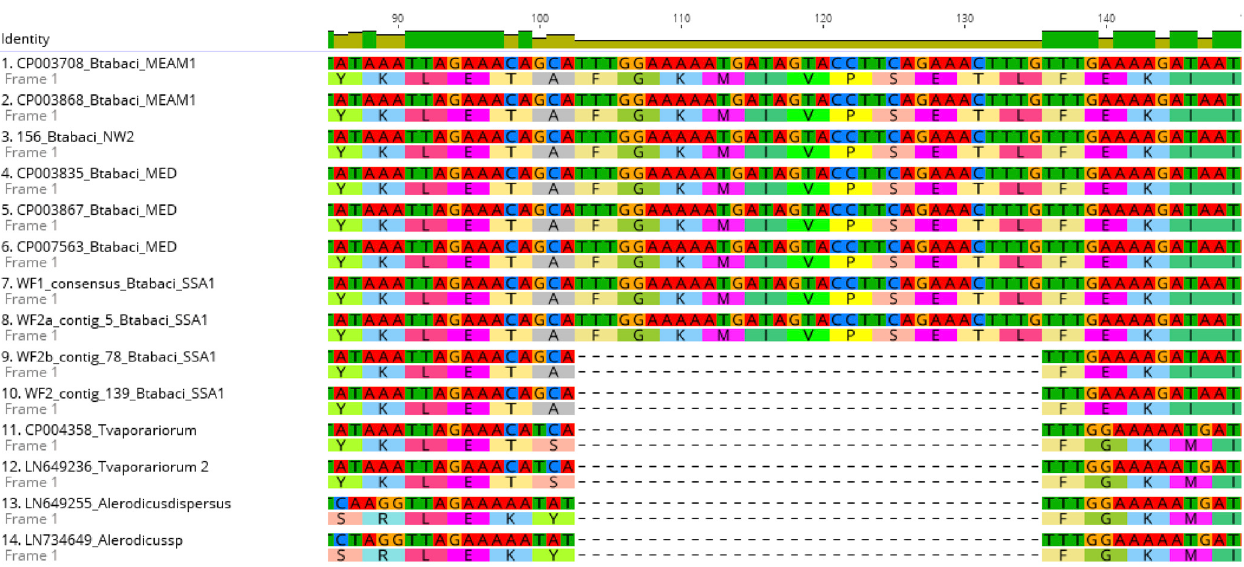
Figure 1. Sequence alignment of nucleotide sequences of Nus G gene in P. aleyrodidarum across whitefly species sequences using MAFFT v